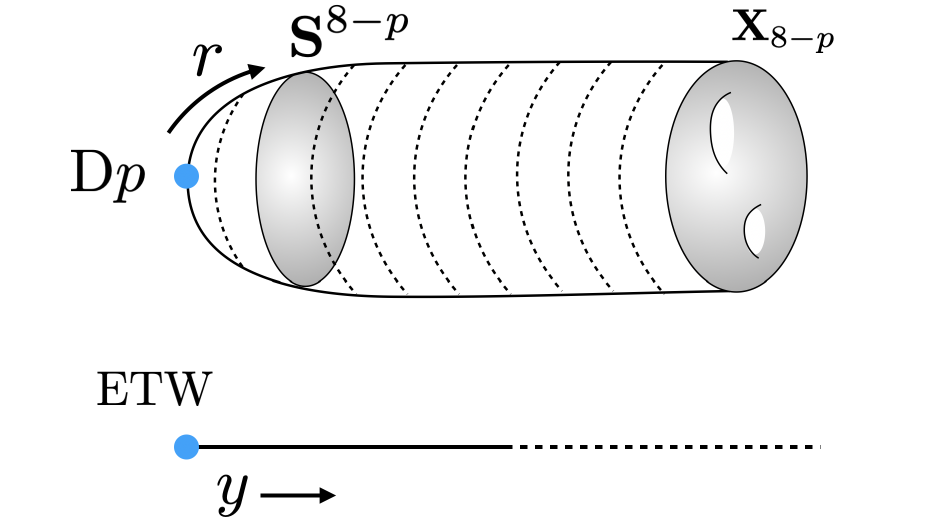
Figure 1 . D p -branes as cobordism defect in theories with (8 − p ) compact dimensions from the higher and lower dimensional perspective. Our local ( p + 2) -dimensional description of the S 8 − p -truncation corresponds to the local structure of a Dynamical Cobordism of a more general compactification on X 8 − p